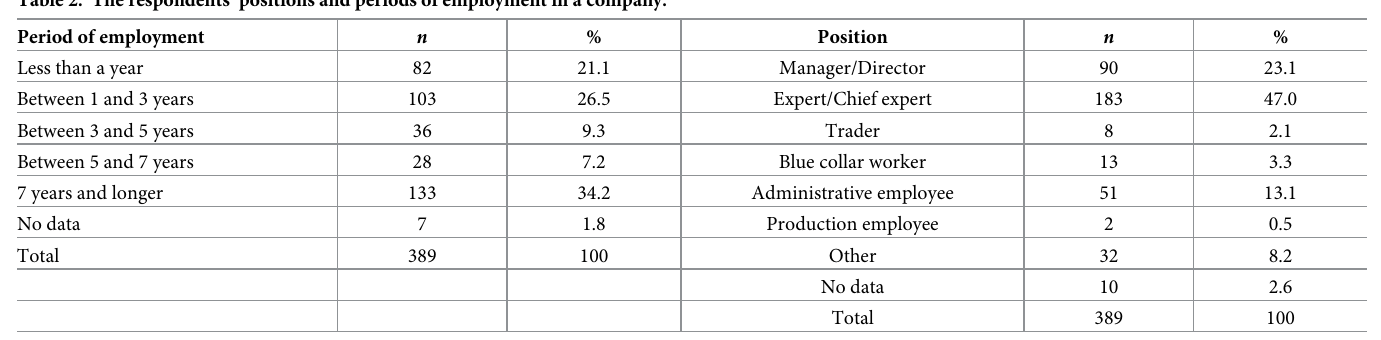
Table 2. The respondents’ positions and periods of employment in a